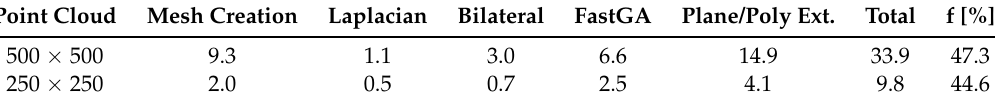
Table 11. Mean Execution Timings (ms) and Accuracy of Polylidar3D on SynPEB.